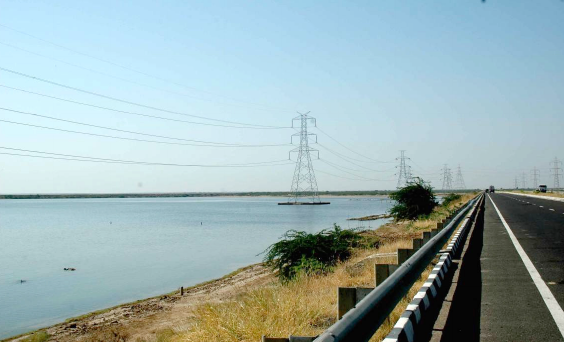
Table 1). Huge electric transmission lines run parallel to the salt pans and cross the Hadakia Creek at Surajbari